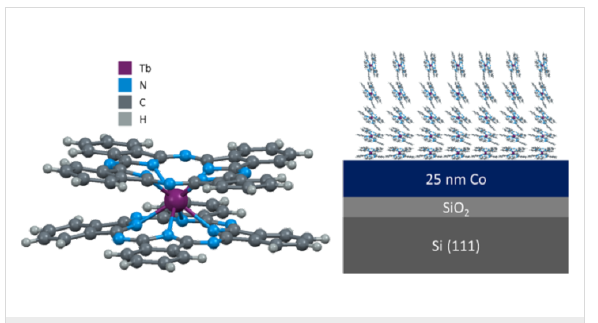
Figure 1: TbPc 2 molecule (left). Investigated layer stack: TbPc 2 thin films on cobalt grown on SiO 2